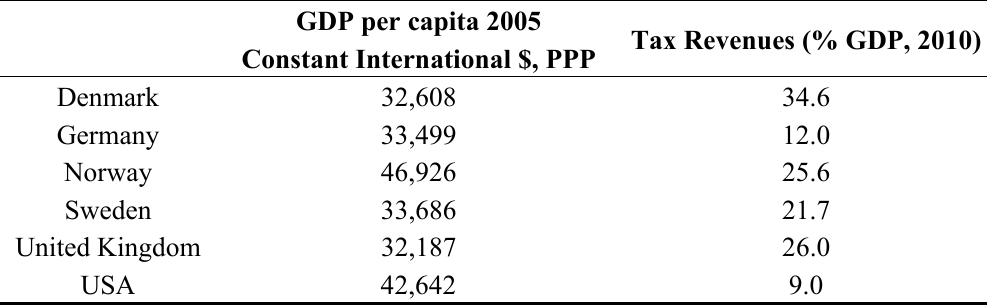
Table 1. Tax revenues (% GDP, 2010) and GDP per capita in selected